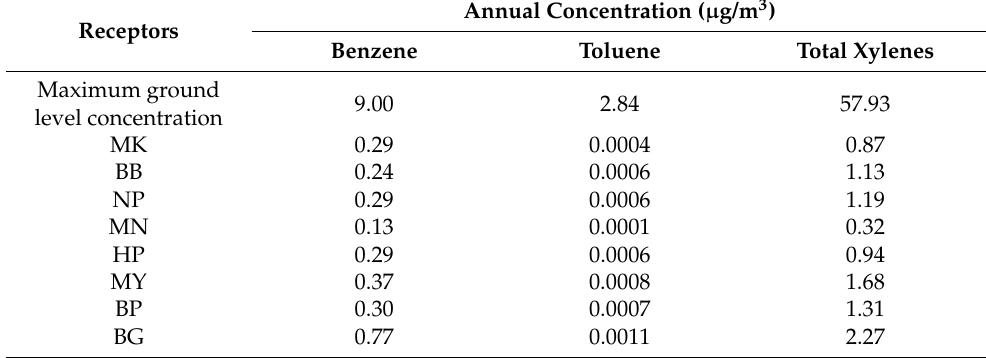
Table 6. Predicted concentrations at the